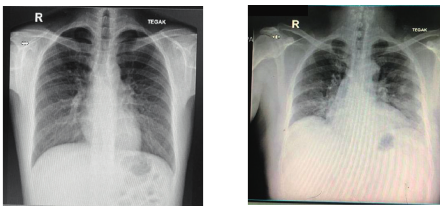
Figure 2: Chest X-rays of the patients. (a) Chest X-ray revealed a typical COVID-19 radiological appearance of diffuse infiltrate at the base, which extended to the periphery of the lungs. (b) Chest X-ray revealed a typical COVID-19 radiological appearance of basal nodular infiltrate at the periphery of the lungs, especially dominant in the left side.